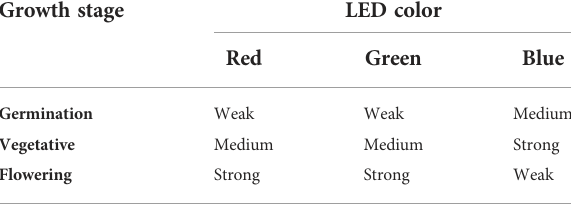
TABLE 2 Fuzzy associative matrix (Group